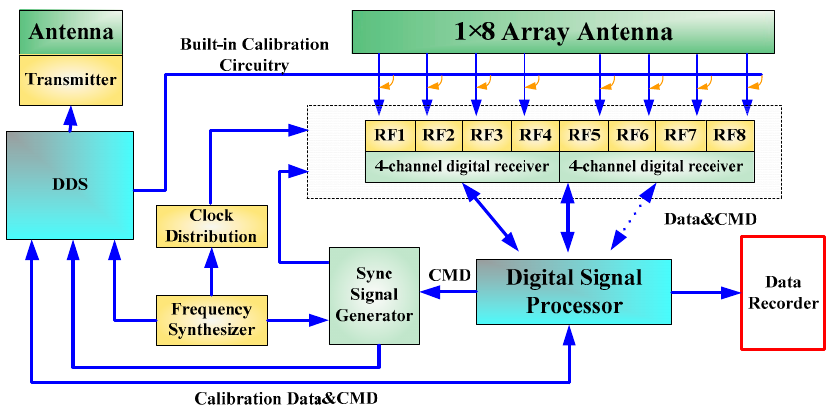
Figure 11. The architecture of the wideband DAR Figure 10. The architecture of the wideband DAR test-bed. Figure 10. The architecture of the wideband DAR test-bed.